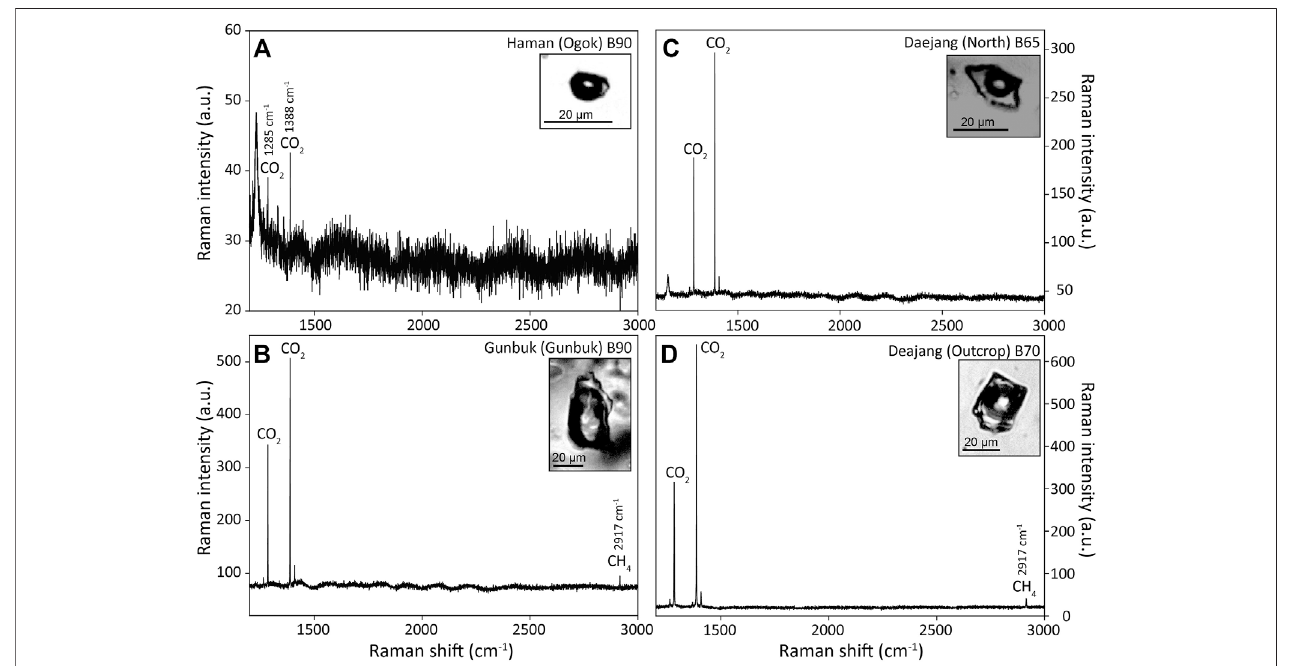
FIGURE 11 | Raman spectra of a bubble part of the vapor-rich inclusions hosted in quartz veins of the (A) Haman, (B) Gunbuk, and (C,D) Daejang deposits. CO 2 (signals at 1,285 and 1,388 cm − 1 ) was detected in the three deposits, whereas CH 4 (signal at 2,917 cm − 1 ) was detected in (B) the Gunbuk and (D) Daejang deposits.